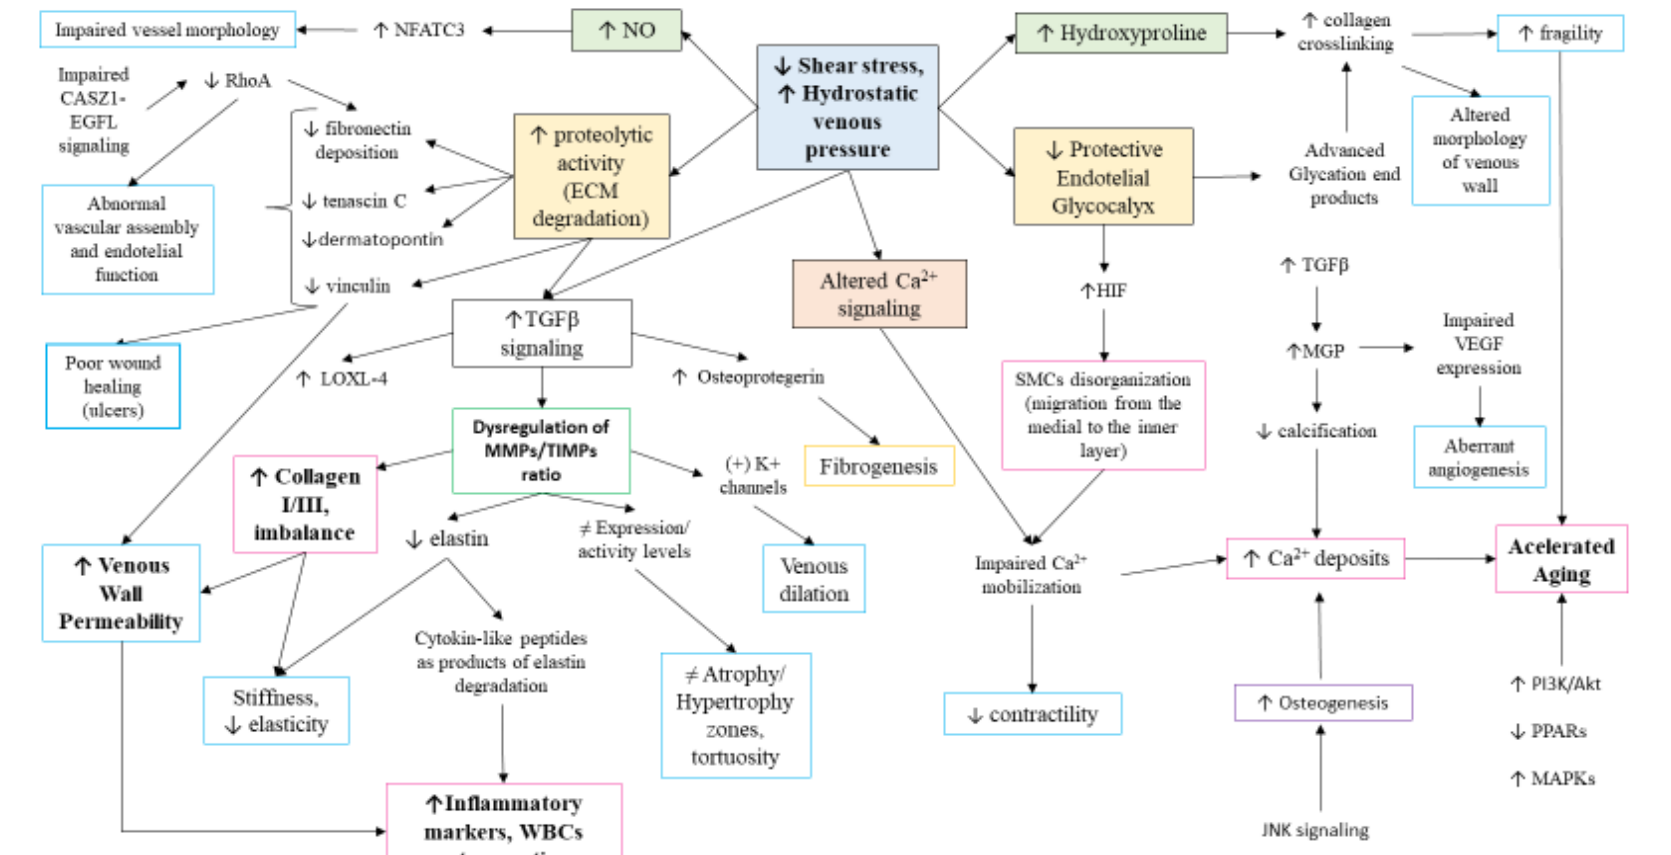
Figure 4. Schematic representation of molecular changes induced in venous structure resulting in different biophysical properties. As previously described altered (mostly decreased) shear stress and venous hypertension are responsible for the venous wall remodeling in VVs, influencing a plethora of molecular pathways. An increased level of hydroxyproline, reduced protective endothelial glycocalyx, altered calcium signaling, imbalance in matrix metalloproteinases and their inhibitors, enhance ECM degradation and augmented nitric oxide are the most important effects described. Collectively, these alterations are responsible for modifications in collagen and elastic fibers, venous wall permeability, disrupted vessel morphology, and functioning and multiple defects associated to the progression of CVD. Legend: Up black arrow= Increased expression; Down black arrow: Decreased expression; ≠ : Differential detection.